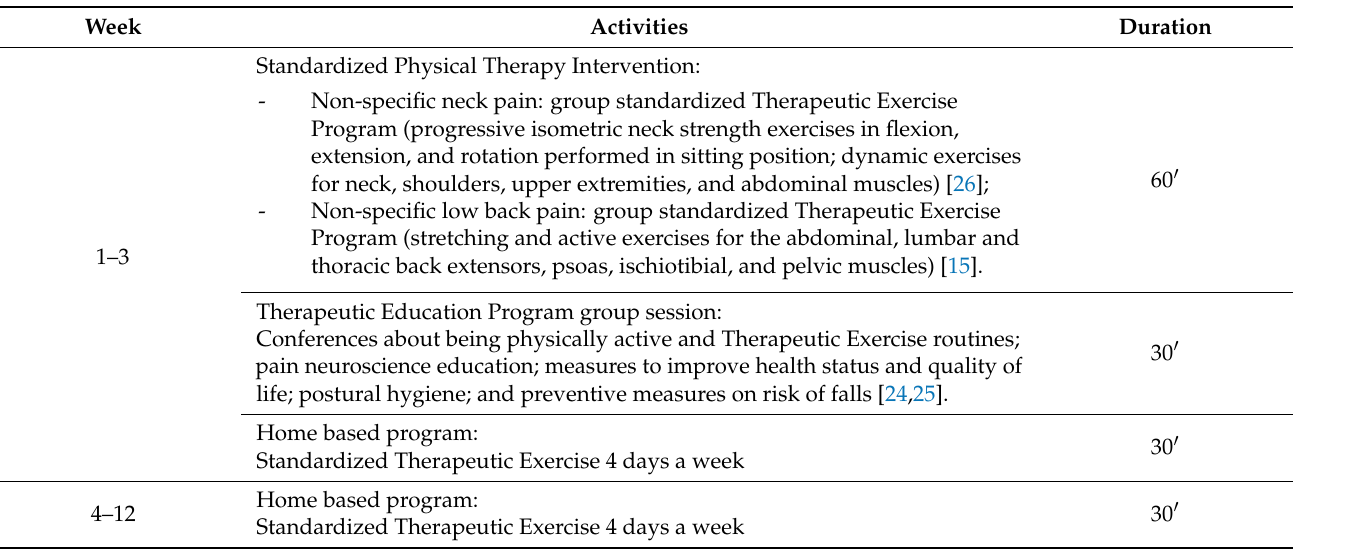
Table 2. Standardized Therapeutic Exercise Group